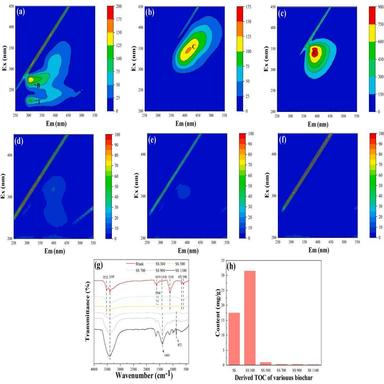
Characterization of DOM derived from SS treated at various temperature (SS, SS 300, SS 500, SS 700, SS 900, SS 1100): (a)~(f) Fluorescence excitation emission matrices of DOM; (g) FTIR spectra of biochar; (h) TOC content of various biochar.